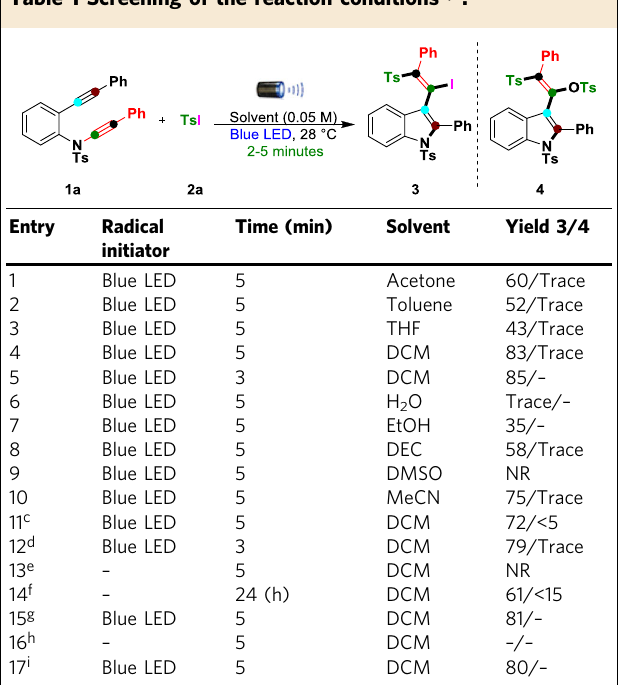
Table 1 Screening of the reaction conditions a,b .